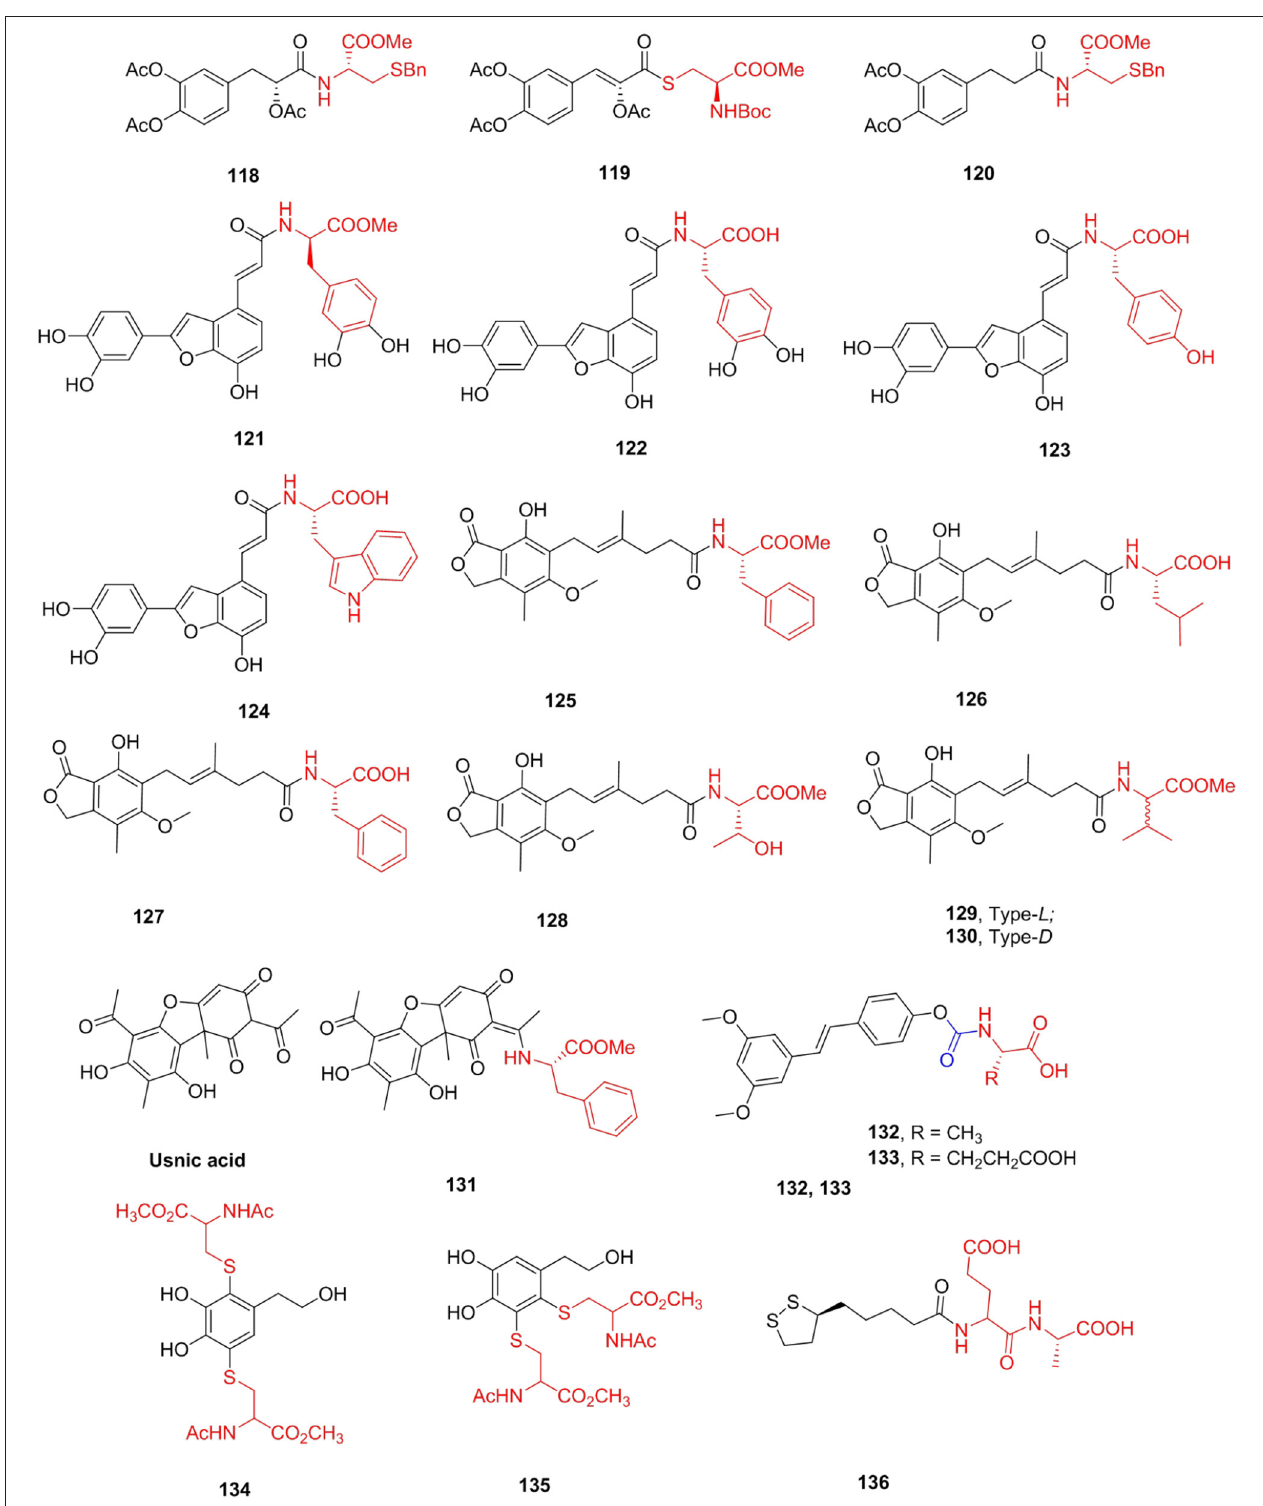
FIGURE 15 | Polyphenols amino acid